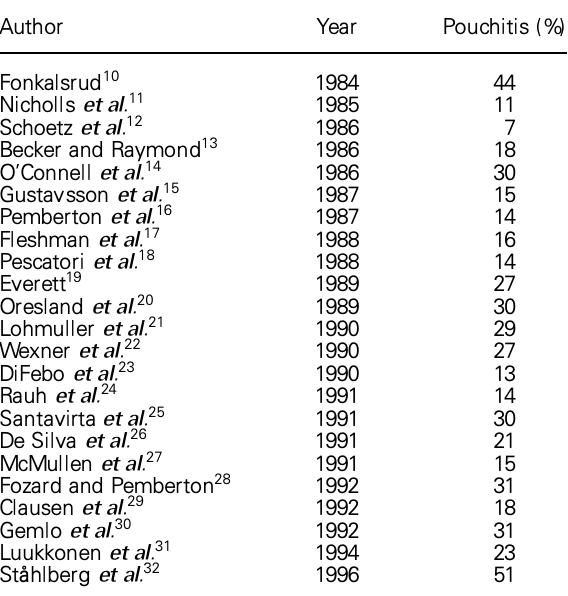
Table 1. Incidence of pouchitis following restorative proctocolectomy Author Year Pouchitis (%) Fonkalsrud